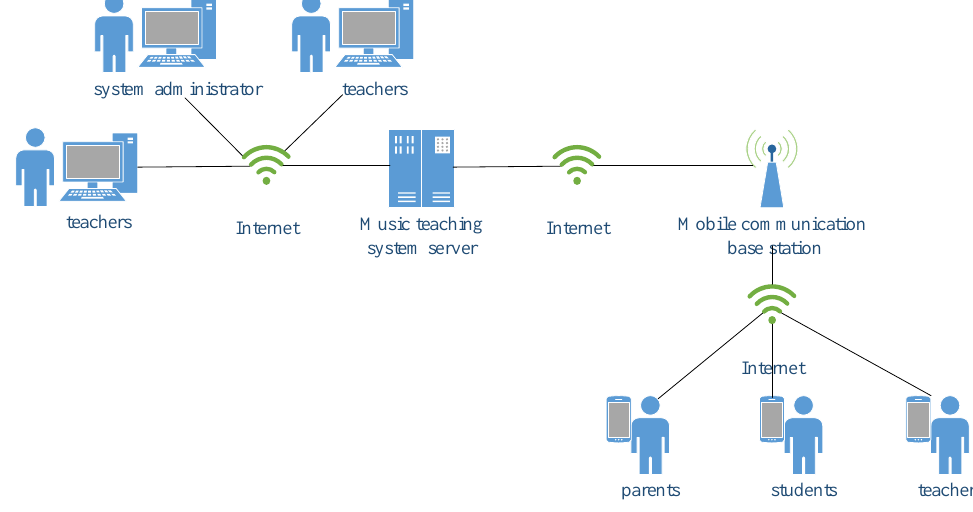
Figure 2. Schematic diagram of physical system